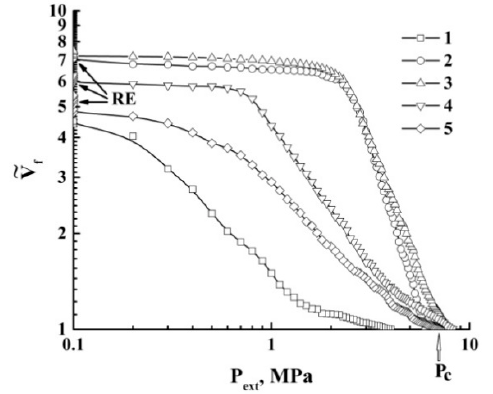
Figure 3. Typical experimental dependencies P ext ( t ) (open circles) and (cid:101) V f ( t ) = V f ( t ) / V f ( 0 ) (filled squares); ( a )—quasi-adiabatic expansion; T ≈ 309.15 K; ( b )—quasi-isothermal expansion; T ≈ 313.15 K; “RE” is the residual expansion stage; “T” is the expansion-to-shrinkage transition. Selectively shown error bars correspond to the confidence level of 0.9.